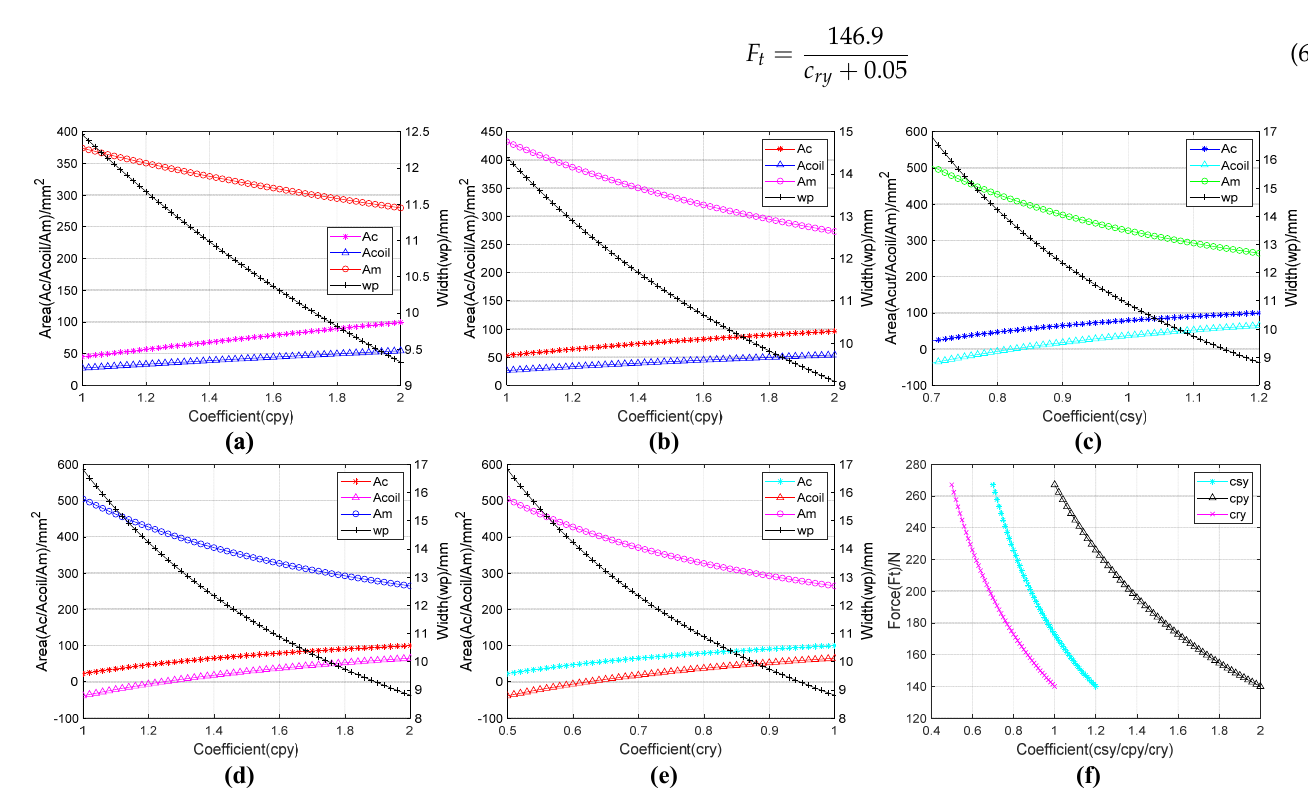
Figure 17. Influence of three coefficient changes on the structure. ( a ) Effect of independent change of coefficient c py . ( b ) Influence of two coefficient changes of c py . ( c ) Three coefficient variation c sy trend. ( d ) Three coefficient variation c py trend ( e ) Three coefficient variation c ry trend. ( f ) Three coefficient variation F t trend.